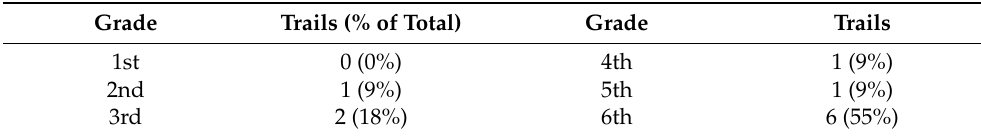
Table 2. Relation of trails and their grade in primary education. Grade Trails (% of